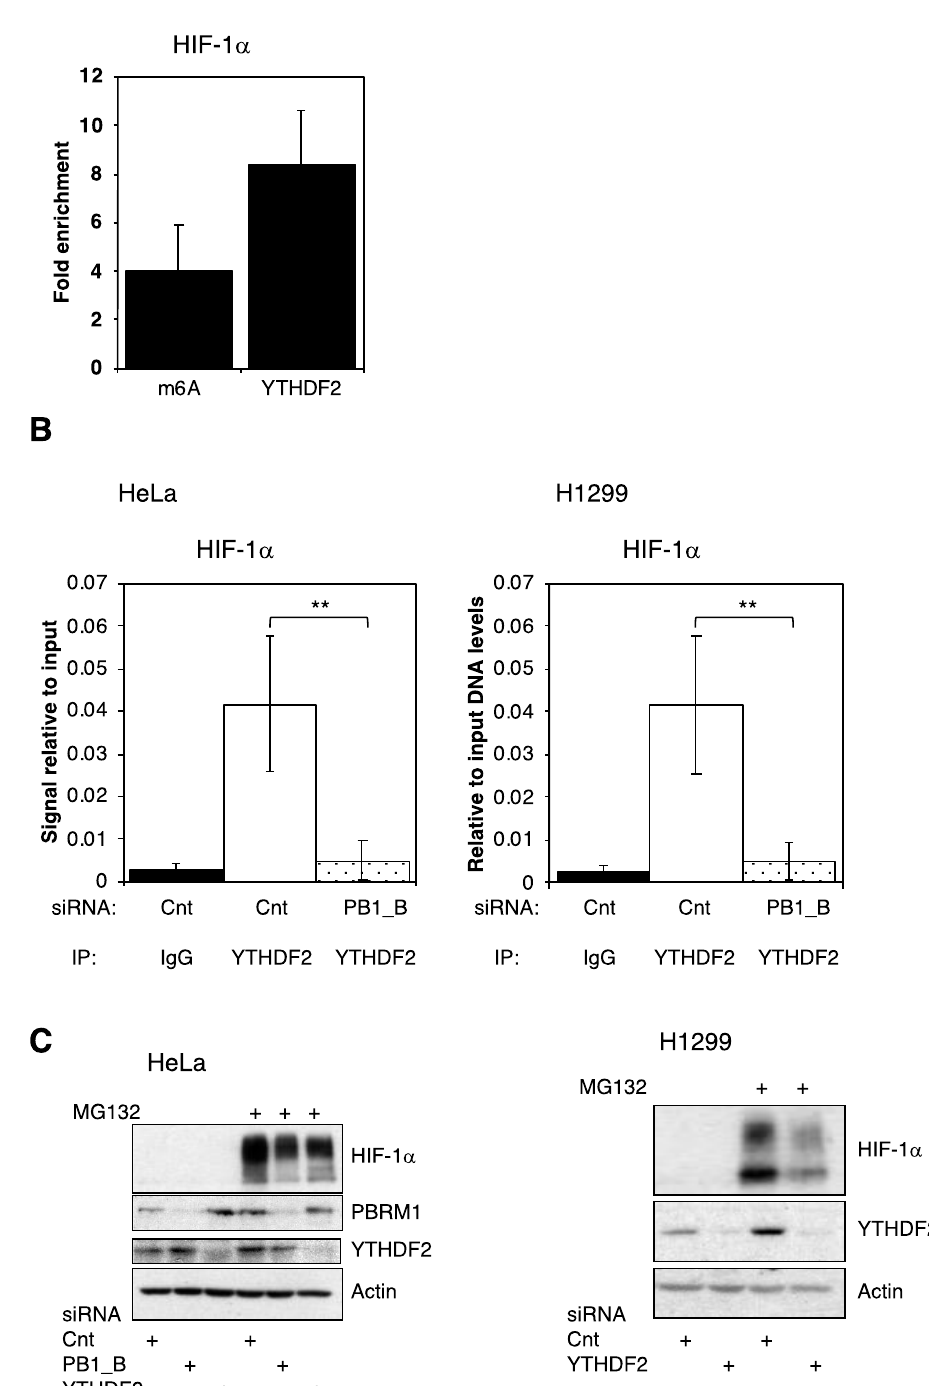
Figure 5. HIF-1 α mRNA is m6A-modified and bound by YTHDF2. ( A ) The HeLa cells were lysed and incubated with either m6A or YTHDF2 antibodies; then, bound HIF-1 α mRNA was analysed by qPCR. ( B ) The HeLa and H1299 cells were then transfected with either control or PBRM1 siRNAs and incubated with the IgG control or YTHDF2 antibodies before analysis of HIF-1α mRNA levels. The means and standard deviations are plotted with Student’s t -test significance indicated (** p ≤ 0.01). ( C ) The HeLa or H1299 cells were transfected with control, PBRM1 or YTHDF2 siRNAs and either DMSO or MG132 for 3 h; then, the cells were lysed and protein levels were determined by Western blotting. +, signifies specific